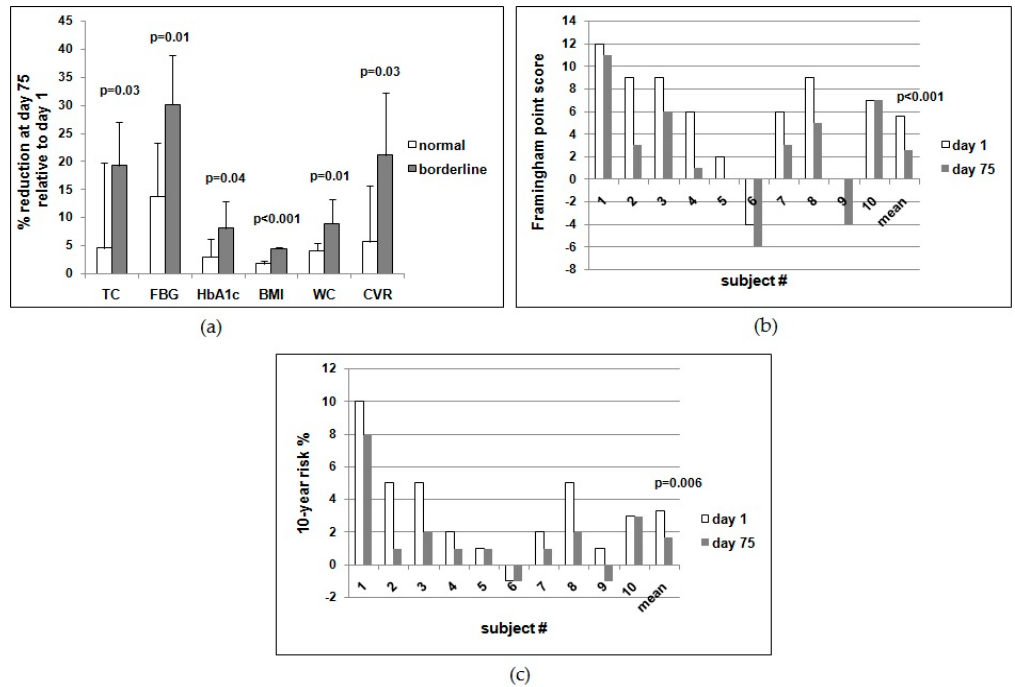
Figure 2. The ABA-rich food supplement taken daily for 75 days improves metabolic parameters in human subjects. In a second experimental protocol, the same volunteers who performed the breakfast experiments were instructed to take one tablet of the ABA-containing food supplement daily before breakfast for 75 days. ( a ) % of reduction at day 75 of the evaluated parameters in normal vs. borderline subjects; ( b ) Framingham point score calculated for each subject at days 1 and 75, ( c ) 10-year % risk for each subject at days 1 and 75. In panels ( b , c ), the last two bars are the mean of all subjects at days 1 and 75 for the considered parameter.